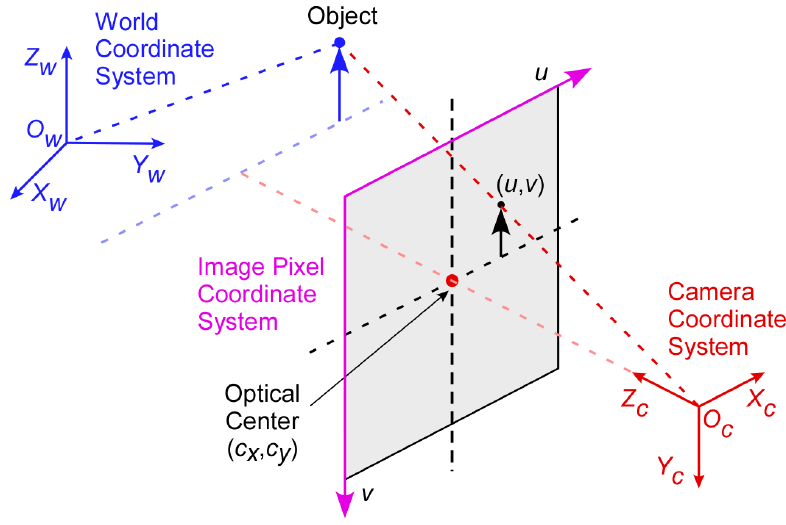
Figure 2. Three coordinate systems used in the camera calibration.